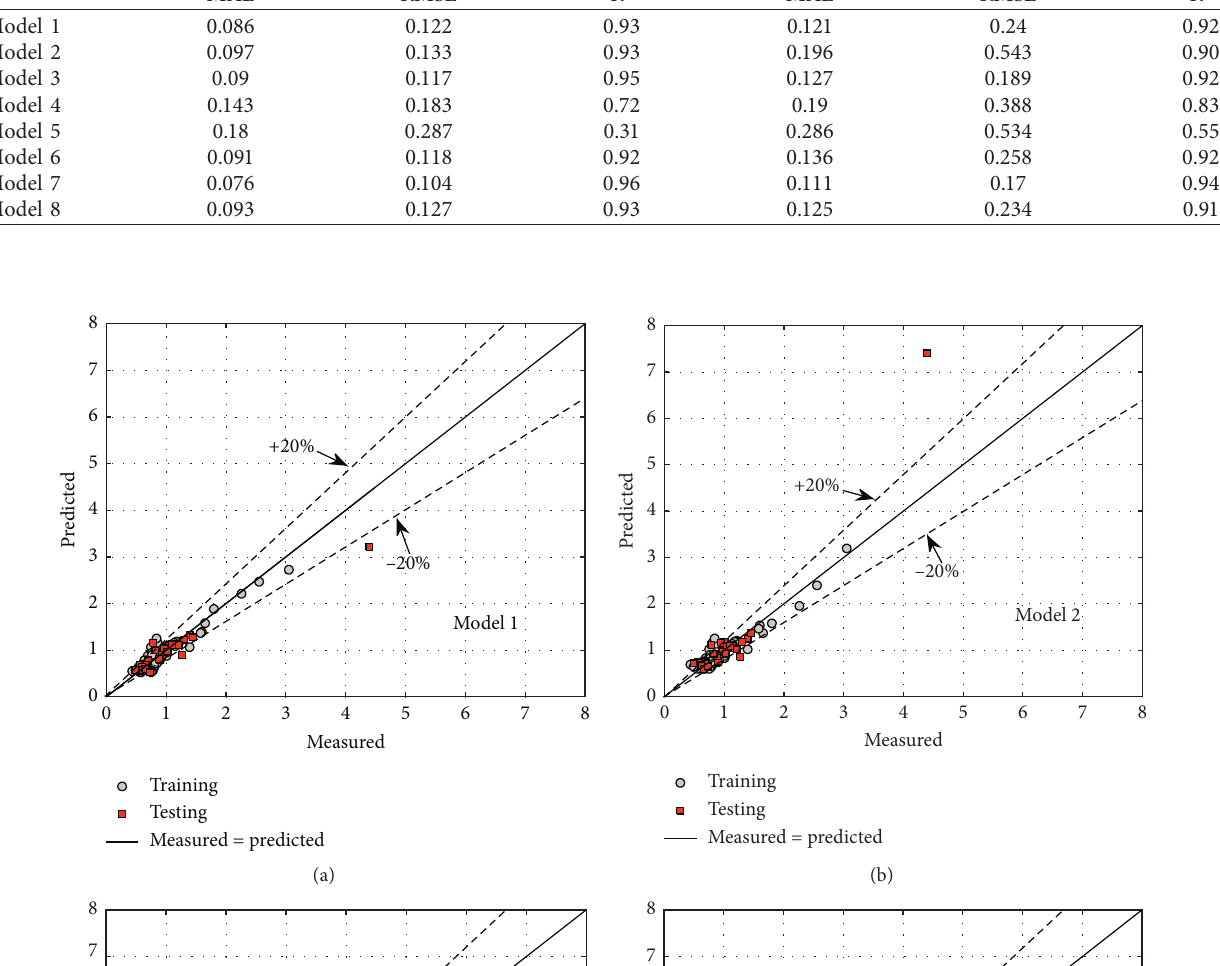
Table 3: Performance of the GEP models in predicting void ratio for training and testing datasets.